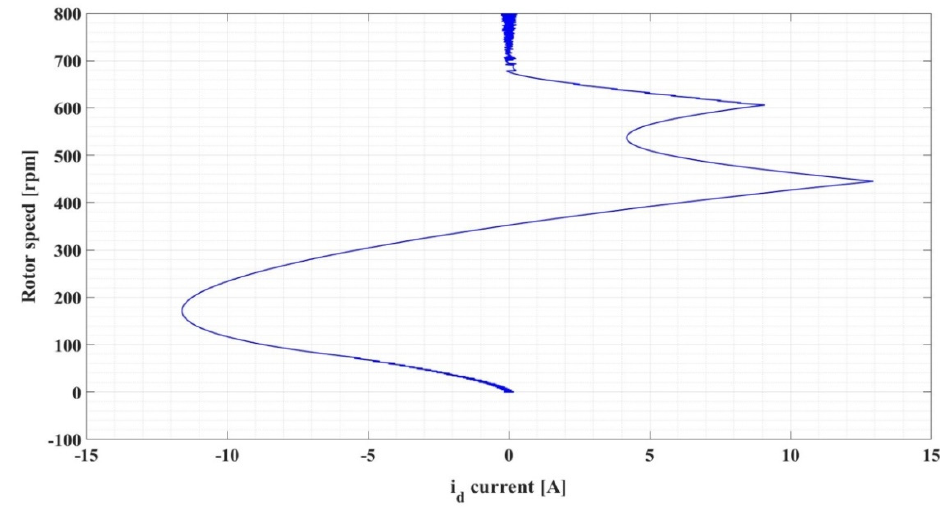
Figure 4. Image of the phase plan: i q current versus i d current.